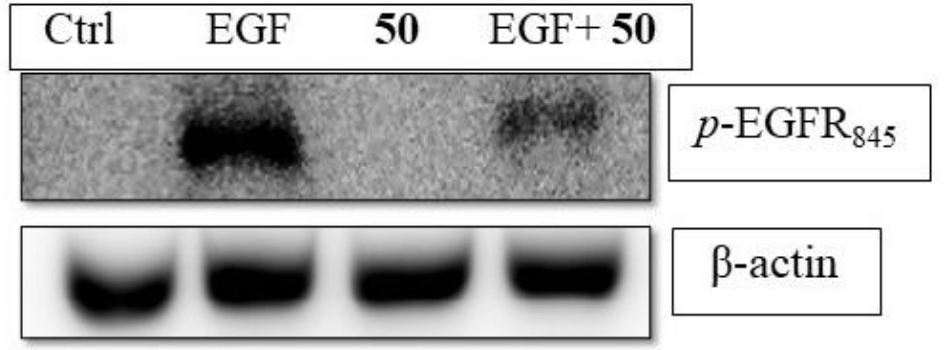
Figure 4. 6,7-Diprenoxycoumarin ( 50 ) antagonized EGF-induced phosphorylation EGFR in Hep3B. The Hep3B cells (1 × 10 6 ) were treated without (Ctrl) or with EGF in the absent 50 or present (EGF + 50 ) of 10 μM 50 for 15 min and phosphorylation status of EGFR was measured.